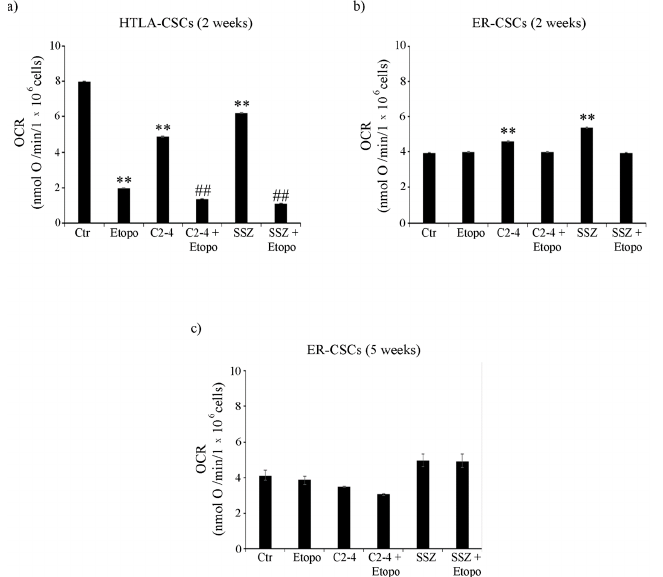
Figure 5. Oxygen consumption rate (OCR) in both CSC populations treated for two ( a , b ) or five weeks ( c ). HTLA-CSCs and ER-CSCs were treated three times a week with 0.1 µM C2-4, with 5 µM SSZ or with 1.25 µM Etoposide, administered once a week alone or in combination with C2-4 or SSZ. Results were reported as nmol O/min/10 6 cells. Bar graph summarizes quantitative data of means ± S.E.M. of three independent experiments. * p < 0.05 vs. untreated CSCs (Ctr); ** p < 0.01 vs. untreated CSCs (Ctr); ## p < 0.01 vs. Etopo- side-treated CSCs.